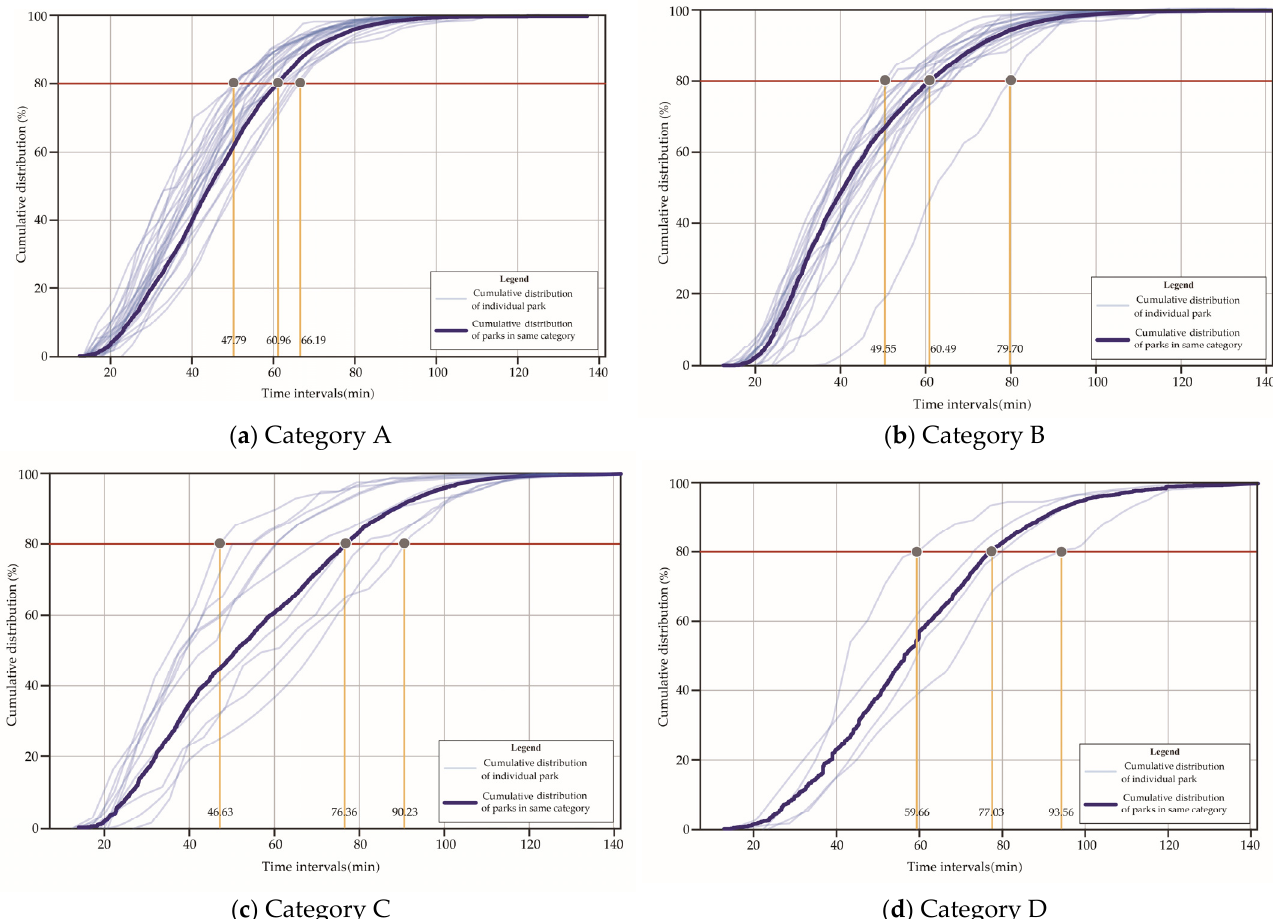
Figure 7. Cumulative distribution of park visitors with time intervals for different categories.